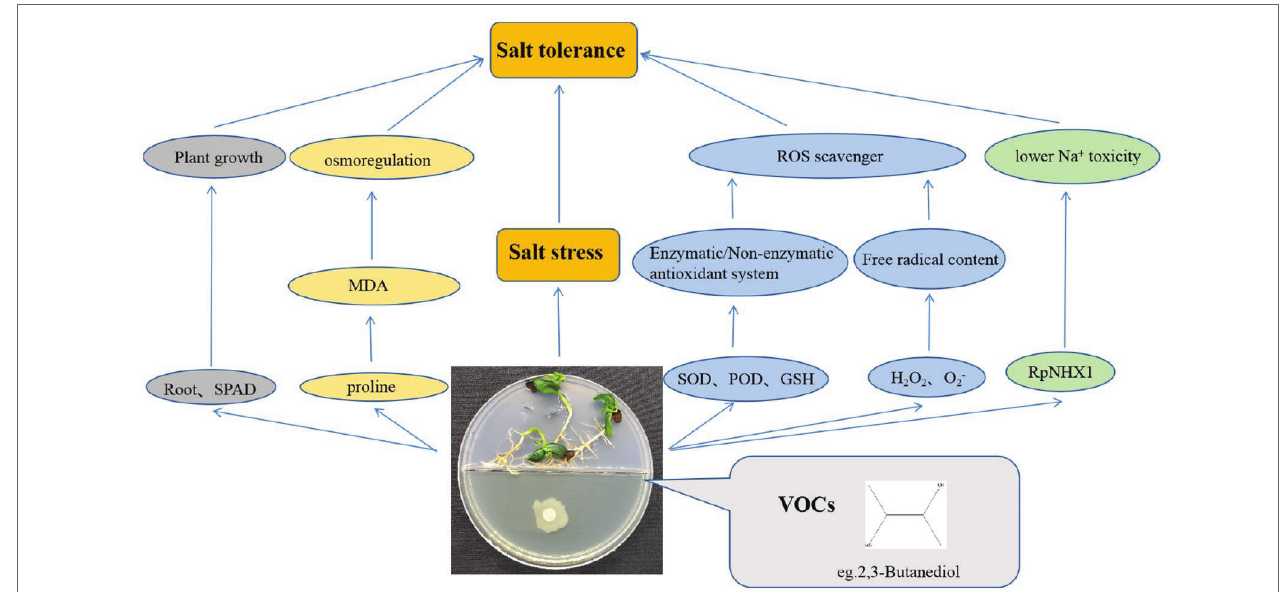
FIGURE 12 | Main pathways of salt tolerance in plants induced by R. aquatilis JZ-GX1 volatile organic